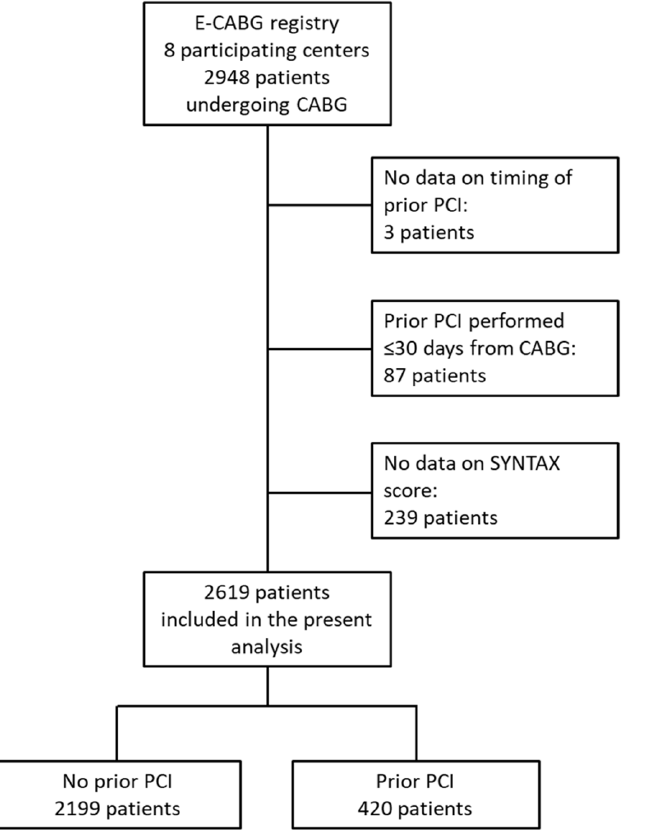
Figure 1. Flow chart of patient selection for the present analysis. CABG: coronary artery bypass grafting; PCI: percutaneous coronary intervention; SYNTAX: synergy between PCI with taxus and cardiac surgery.